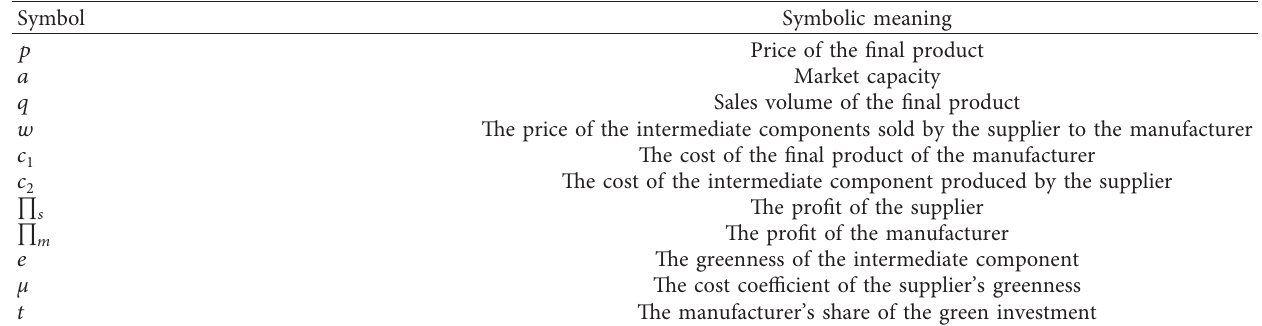
Table 1: Introduction of the